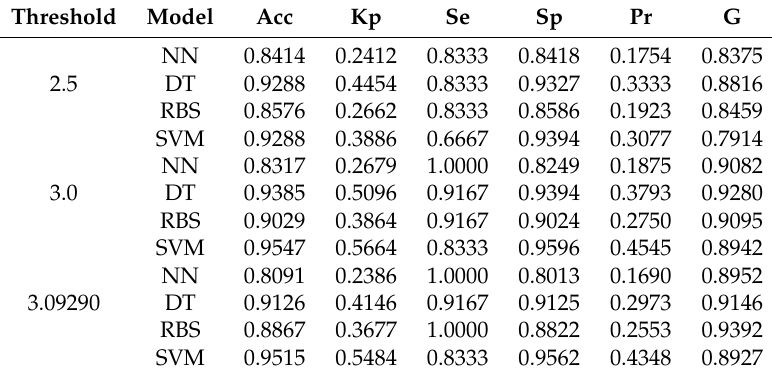
Table 12. Results obtained for the best model for each threshold. Different statistics are shown: the Accuracy (Acc), Kappa factor (Kp), Sensitivity (Se), Specificity (Sp), Precision (Pr) and the Geometric mean (G), all of them computed using Equations (1) to (8). The models are feed forward NN, Decision Trees learned with C5.0 (DT), Rule-Bases Systems learned with C5.0 (RBS) and Support Vector Machines